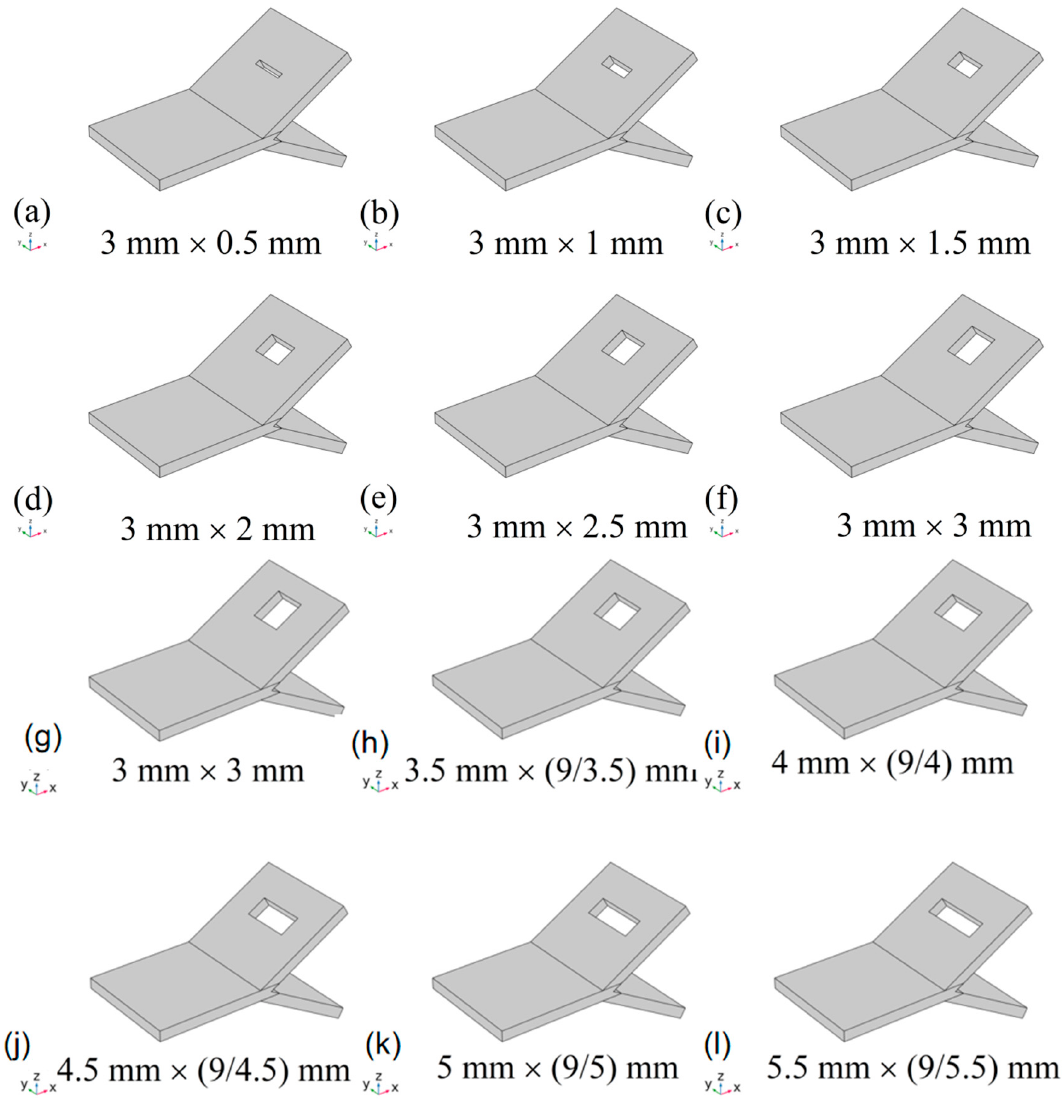
Figure 2. Schematic diagram of the fluid flow.